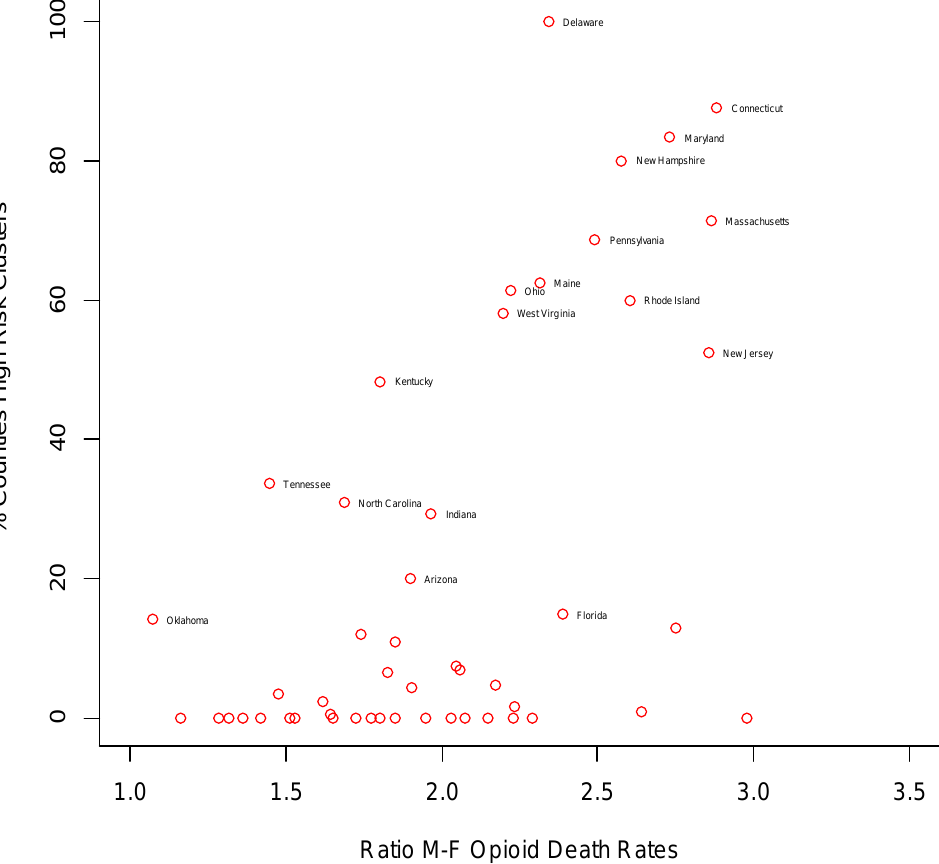
Figure 2. Male–female opioid mortality ratio and high risk drug death clustering.